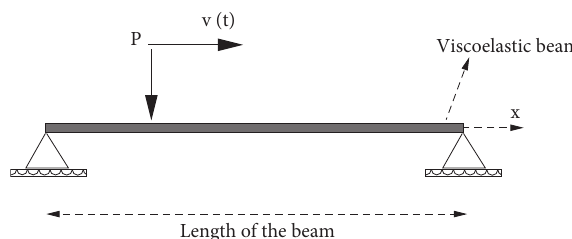
Figure 1: Schematic of the viscoelastic beam under moving force load P with the velocity v ( t )